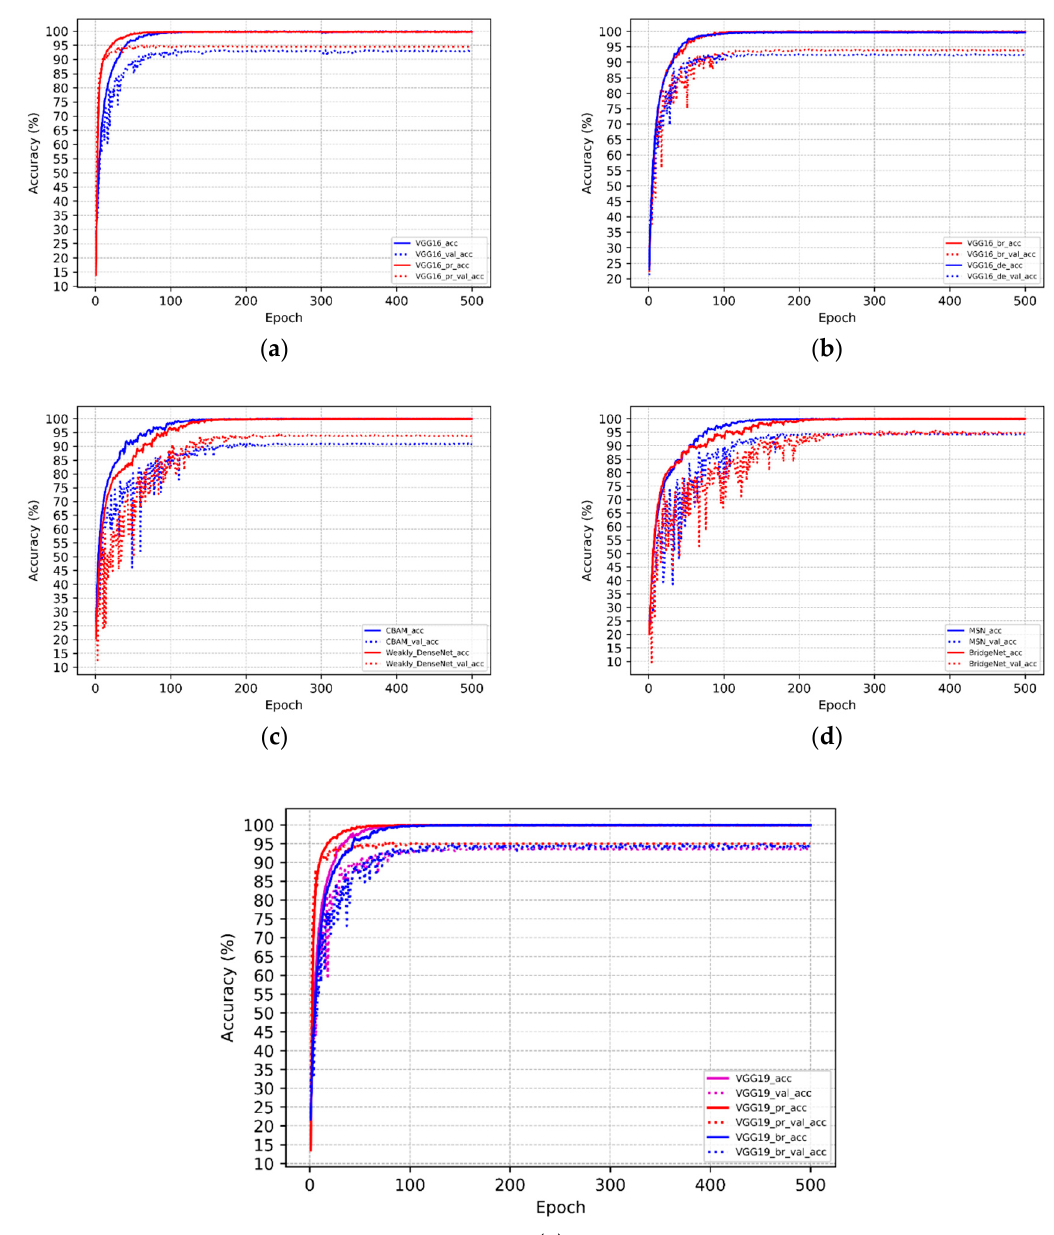
Figure 11. Training process of selected models: “—” denotes training accuracy; “…” represents validation accuracy. ( a ) Red lines are VGG-16 trained with ImageNet pre-training, and blue lines are VGG-16 trained from scratch; ( b ) red lines are VGG-16 with bridge connections, and blue lines are VGG-16 with deformable convolutions; ( c ) red lines are Weakly DenseNet, and blue lines are CBAMNet; ( d ) red lines are BridgeNet-19, and blue lines are MSN-19; ( e ) red lines are pre-trained VGG-19, blue lines are VGG-19 with bridge connections, and magenta lines are VGG-19 trained from scratch.